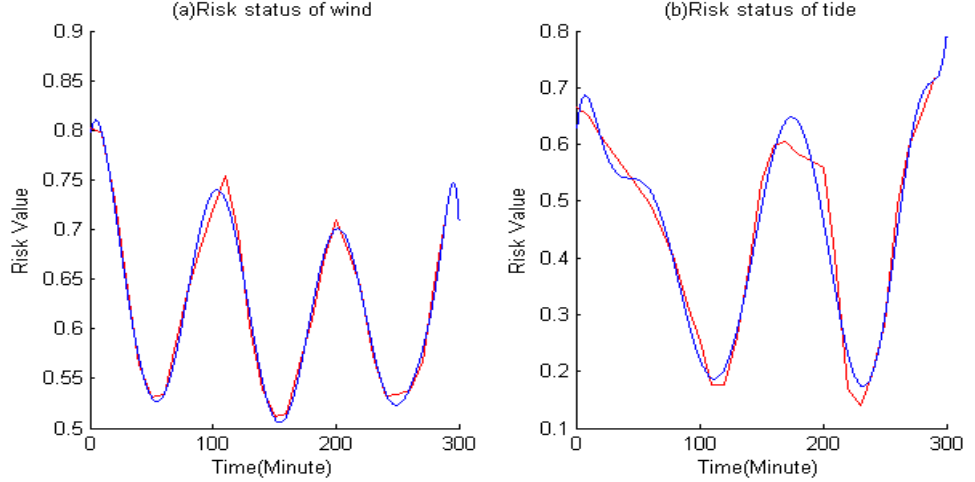
Figure 4. Wind and tide trends over time in the defined scenario.